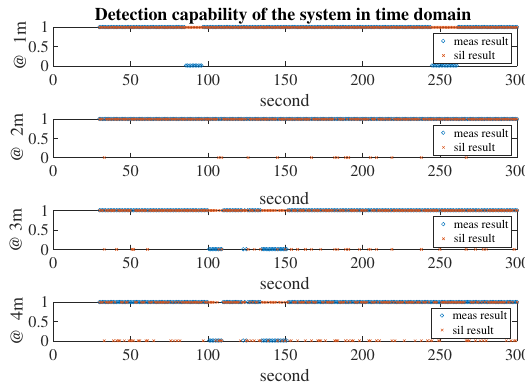
Figure 11. Detection capability of the system in time domain.